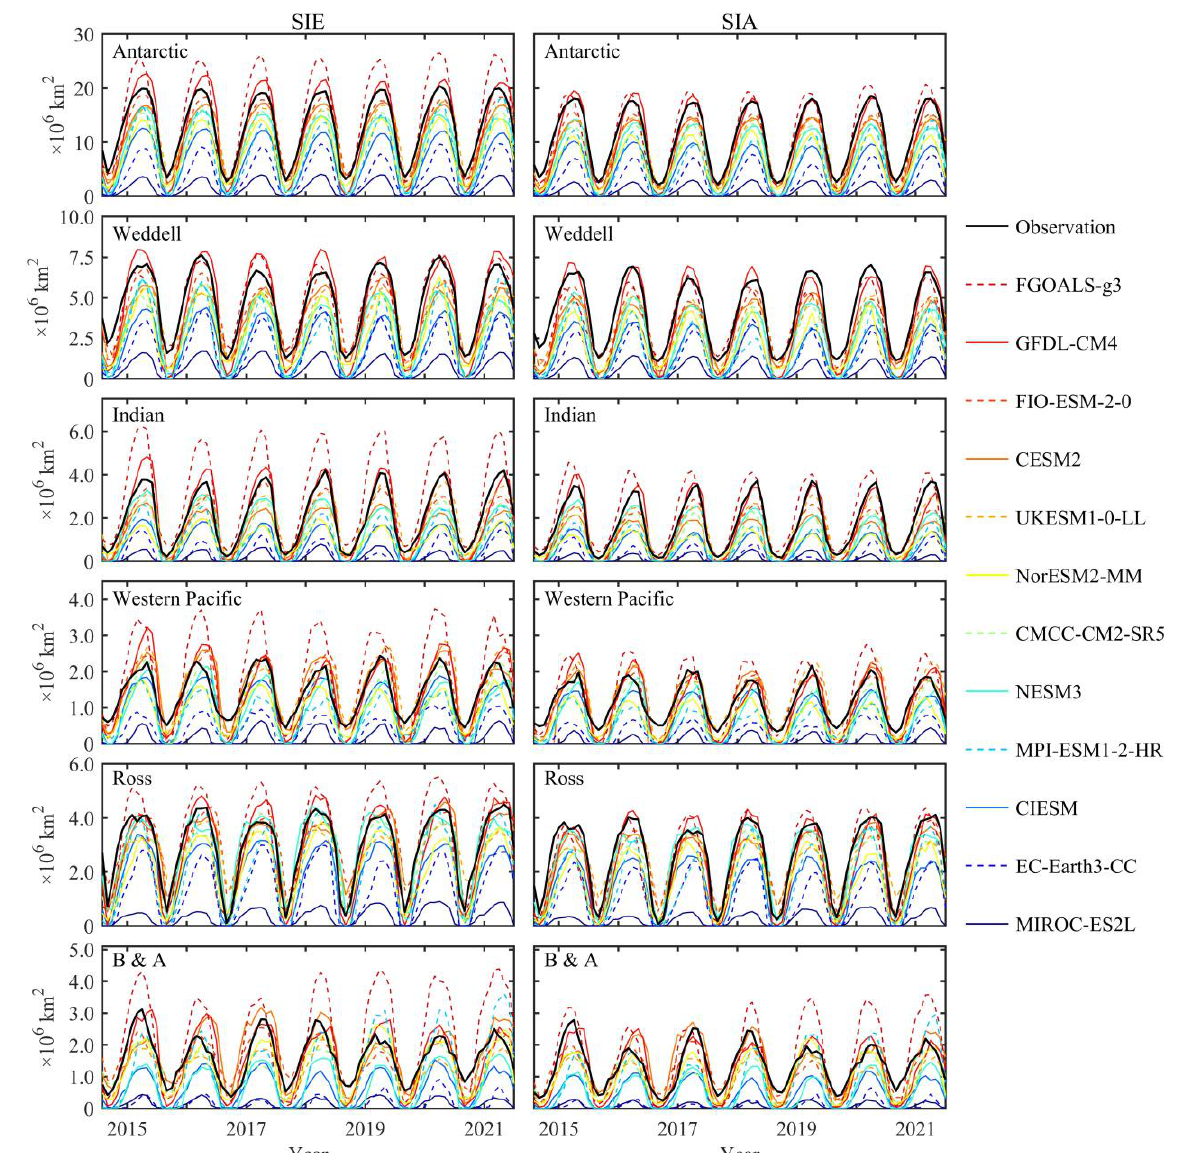
Figure 2. Monthly variation of sea ice extent (SIE) and sea ice area (SIA) for the observation and CMIP6 models in the whole Antarctic and five subregions.